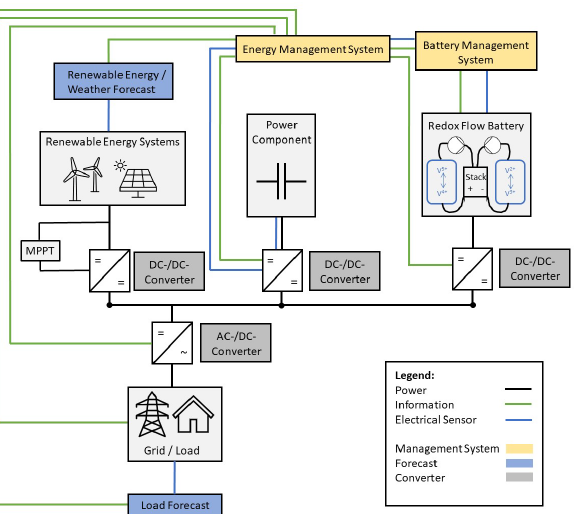
Figure 7. Principle schematic of a HESS including all power, information, and sensor connections between storage components and the grid.